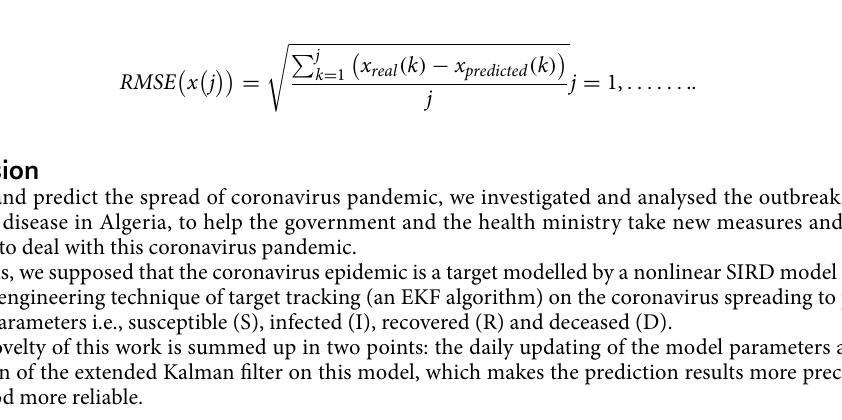
Figure 6. Real and predicted trajectories of daily basic reproduction number R 0